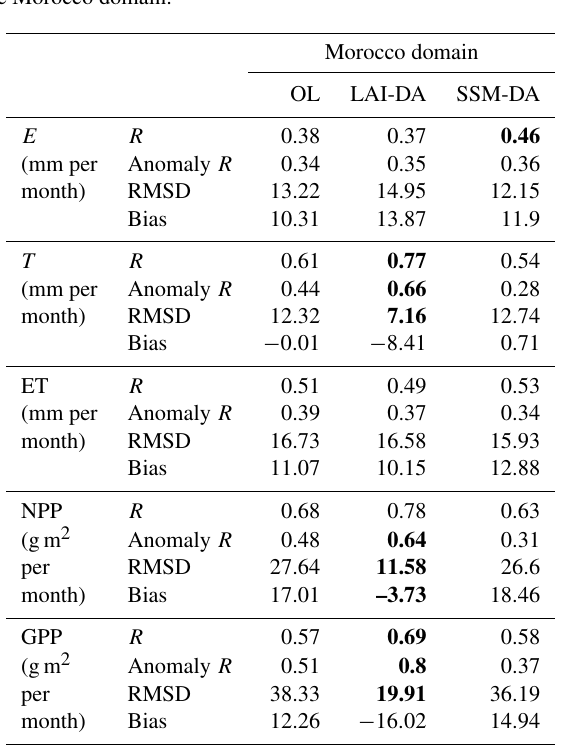
Table 3. Median evaluation metrics of monthly correlation ( R ), anomaly correlation (anomaly R ), RMSD, and bias for the OL, LAI-DA, and SSM-DA simulations against FAO WaPOR data sets for evaporation ( E ), transpiration ( T ), evapotranspiration (ET), net primary production (NPP), and against the FLUXSAT data set for gross primary production (GPP) for the period of 2015–2019 over the Morocco domain.